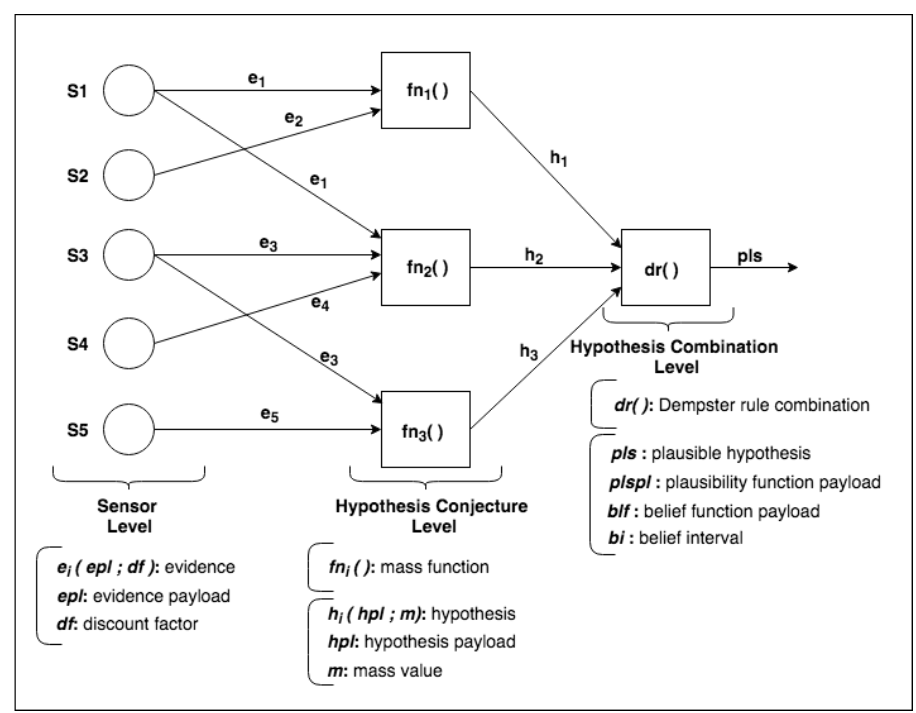
Figure 2. Dempster–Shafer Theory-Complex Event Processing ( DST-CEP ) building block (DSTBB).